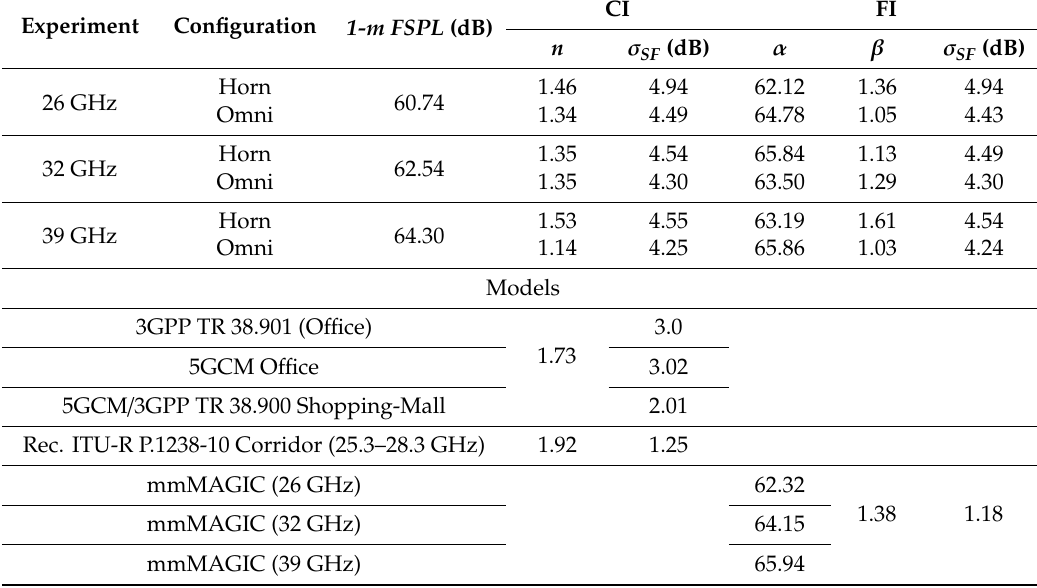
Table 2. Coe ffi cients for the CI and FI fittings and line-of-sight (LOS) models.